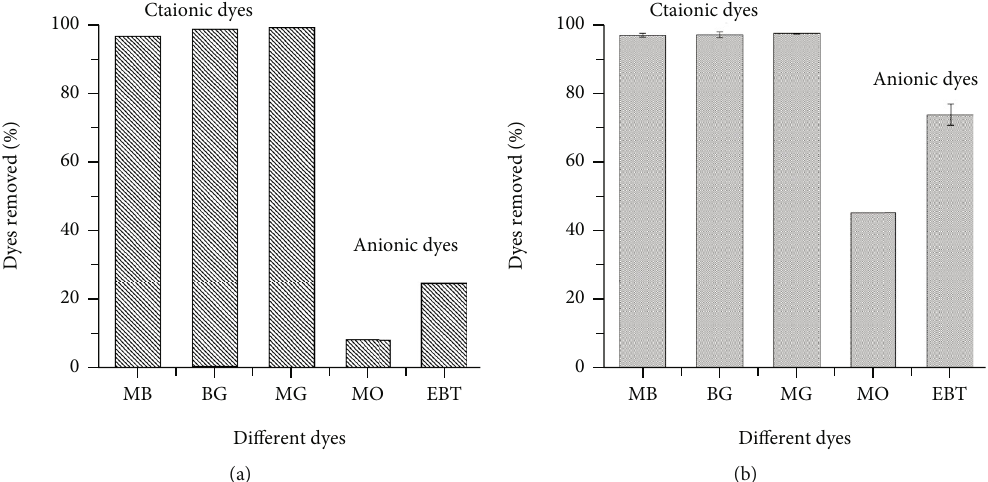
Figure 3: Adsorption performance of BB (a) and EVML (b) for di ff erent cationic and anionic dyes (conditions: initial concentration of the dyes 10mg/L, adsorbent dose 2.5g/L, agitation time 24 h, shaking speed 200rpm, and temperature 25 ± 1 ° C ).